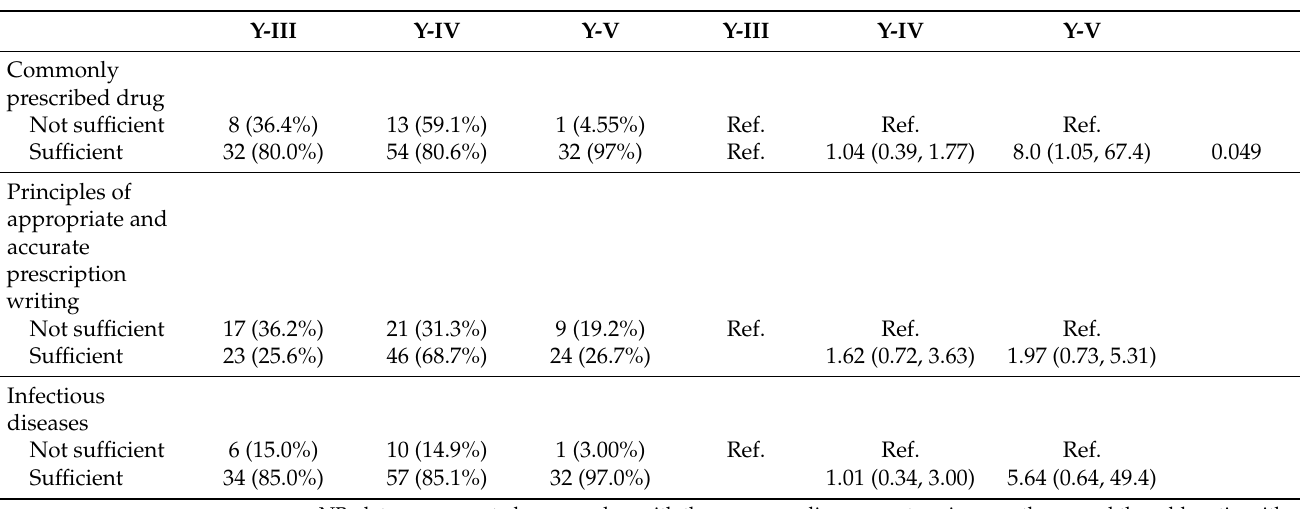
Table 3. Frequency and odds of different student years in the formal education and training sufficiency and confidence in pharmacology.